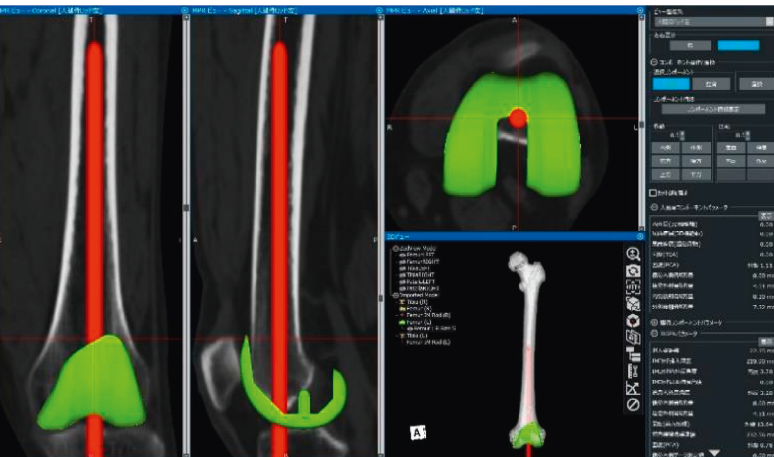
Figure 1: Preoperative planning using Jig Engaged 3D Pre-Operative Planning Software for the TKA operation support